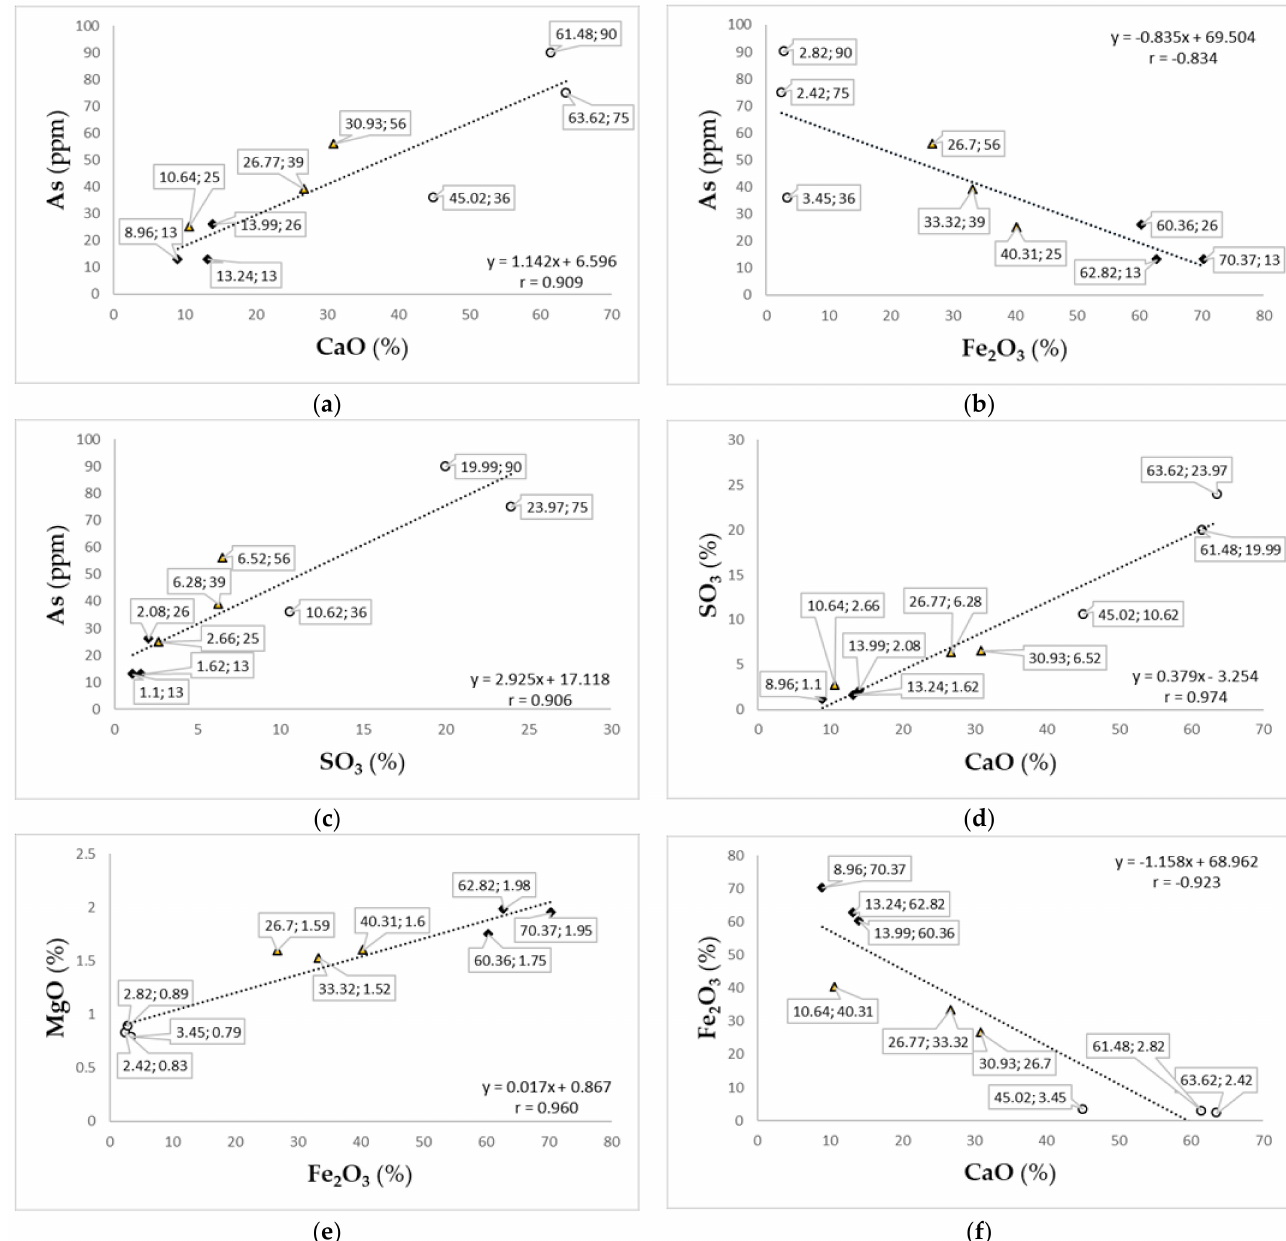
Figure 5. Relationships between the concentrations of ( a ) As–CaO, ( b ) As–Fe 2 O 3 , ( c ) As–SO 3 , ( d ) SO 3 –CaO, ( e ) MgO–Fe 2 O 3 , and ( f ) Fe 2 O 3 –CaO (black squares are used for highly magnetic fractions, yellow triangles for less magnetic ones, and circles for non-magnetic